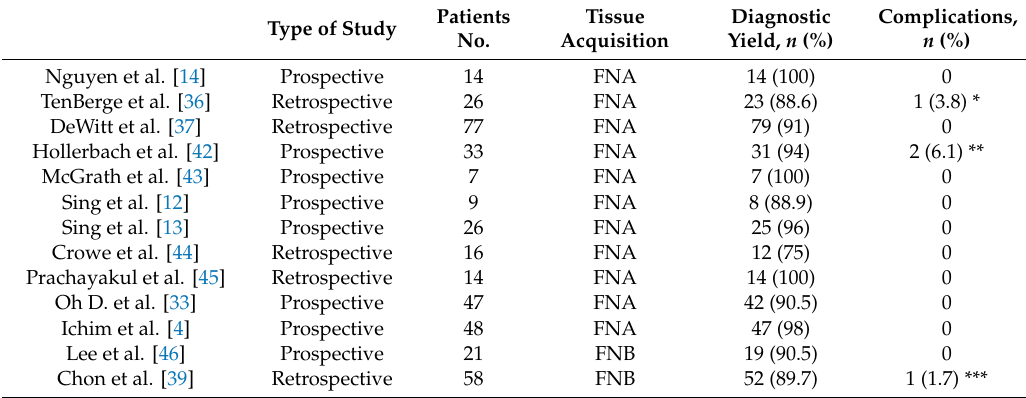
Table 1. Studies reporting endoscopic ultrasound (EUS)-guided liver fine needle aspiration / fine needle biopsy (FNA / FNB) in focal liver lesions.